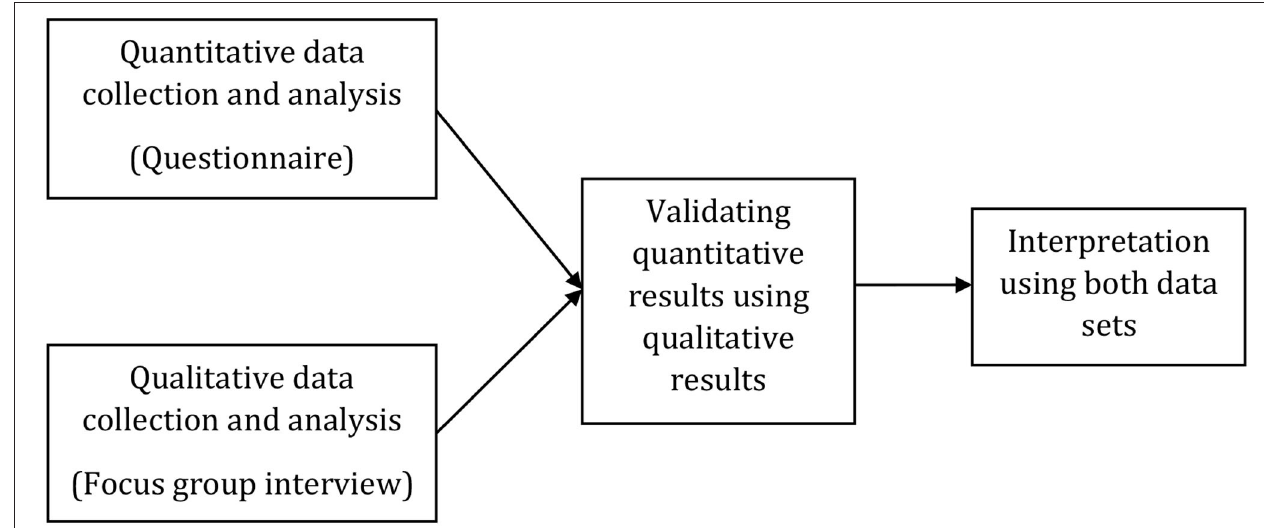
FIGURE 3 | Research design